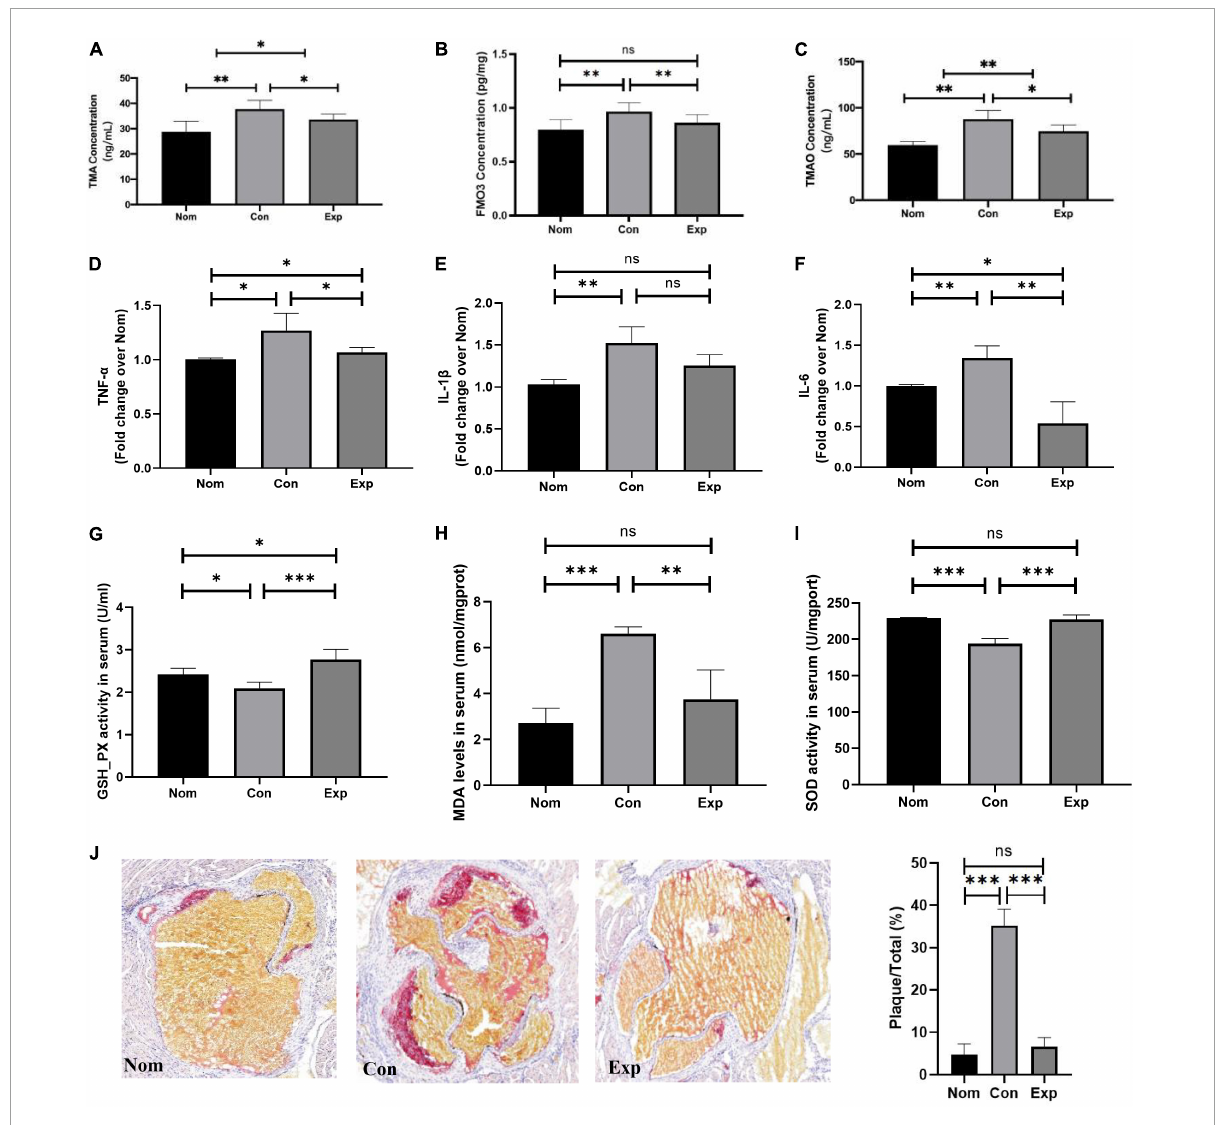
FIGURE3 β -sitosterol protected ApoE − / − mice from choline-induced atherosclerosis (AS). (A–C) β -Sitosterol modulated choline metabolism. (D–I) β -sitosterol reduced proinflammatory cytokines and antioxidant activity. (J) β -sitosterol reversed the atherosclerotic lesions. The aortic root was assessed by Oil Red O staining, and the plaques area were quantified by ImageJ. Values are presented as the mean ± SD. ∗ p < 0.05; ∗∗ p < 0.01; ∗∗∗ p < 0.001, ns = not significant.